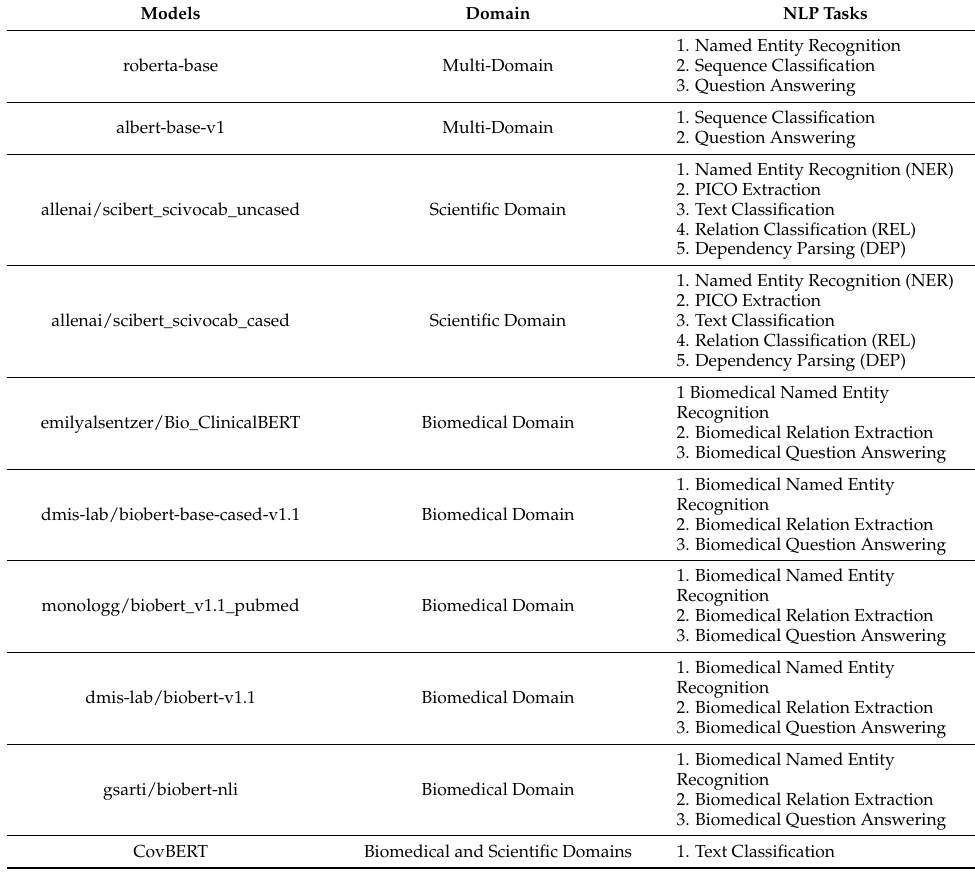
Table 4. BERT’s variants, relative domain and NLP